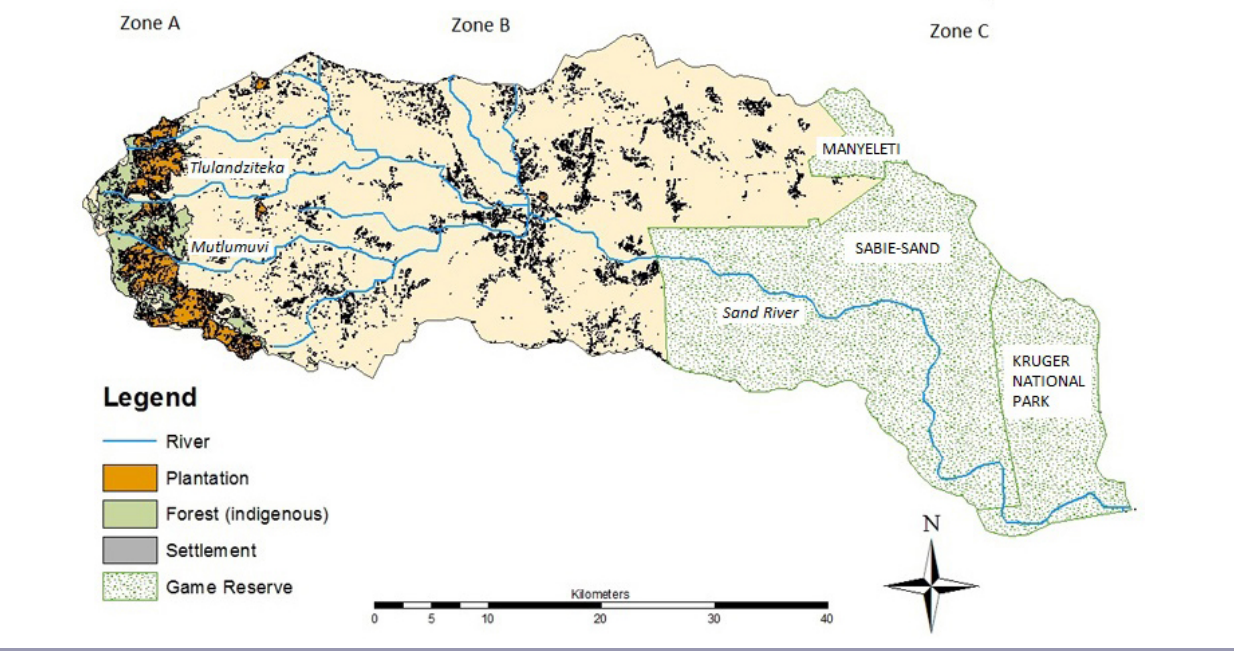
Fig. 1 . Map of the Sand River Catchment, showing the three major zones that comprise the